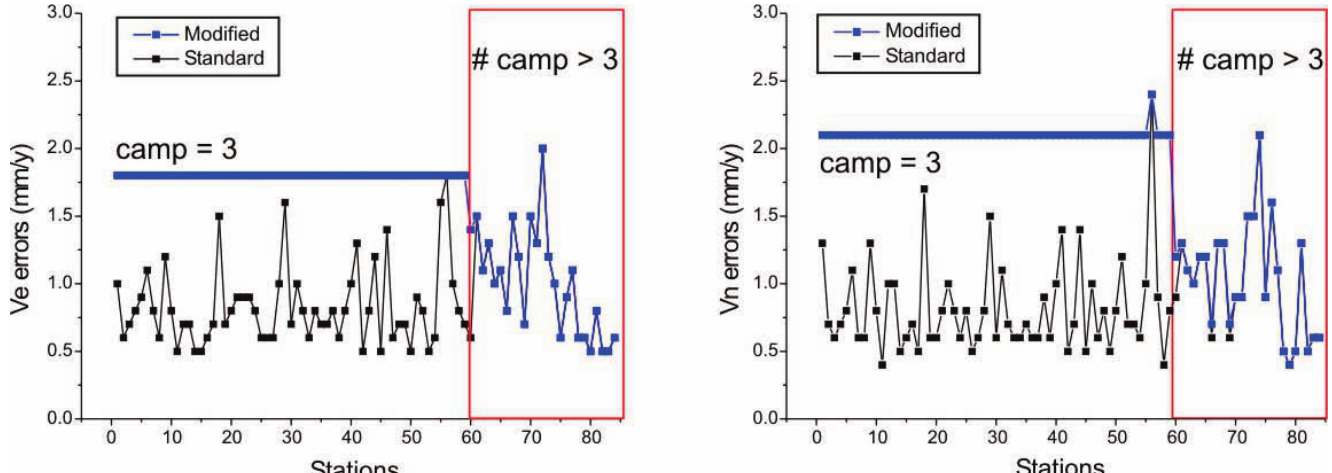
Figure 5. Errors of the east and north velocity components related to the CAGeoNet stations, including both the standard and the modified errors corrected with thresholds. Since the NPSs measured using three campaigns show standard errors lower than the computed thresholds, their errors are replaced by the corresponding thresholds. In contrast, NPSs measured more than three times are characterized by errors that overcome the thresholds, and their final errors (blue) coincide with the standard errors. The station numbers along the abscissa are as listed in Table 1. The ordinate axes are labeled as «V error» to highlight the corrected errors dataset (blue